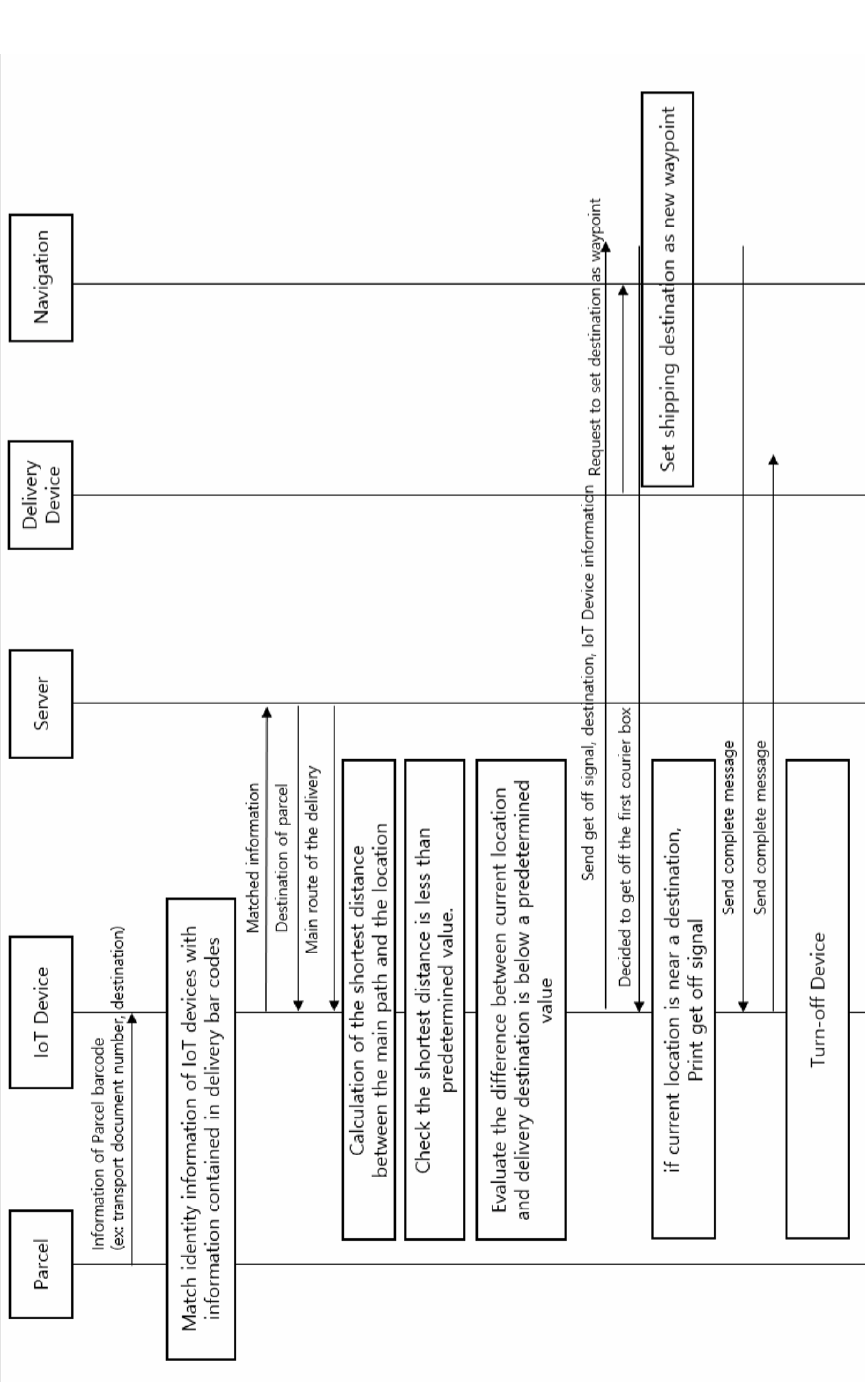
Figure 4. Sequence diagram of Improved Parcel Delivery System: IoT Devices